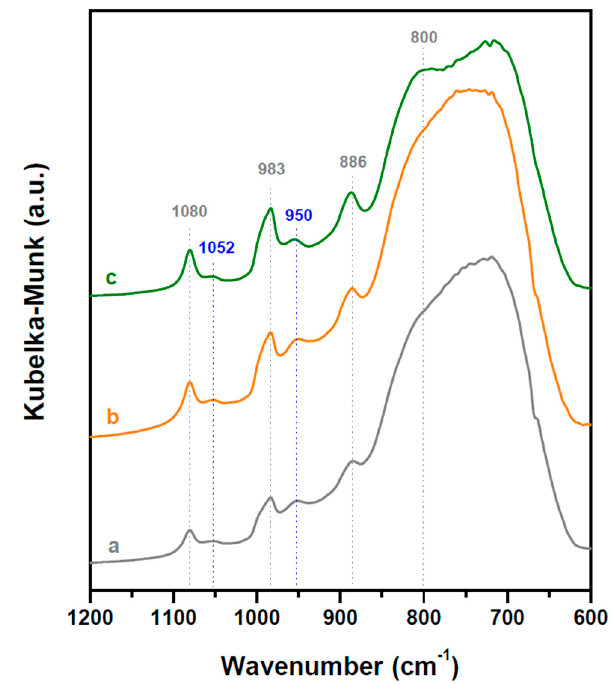
Figure 11. DRIFT spectra of CZA-xHPW / Ti hybrid catalysts: CZA-1.4HPW / Ti (a), CZA-1.7HPW / Ti (b) and CZA-2.7HPW / Ti (c).